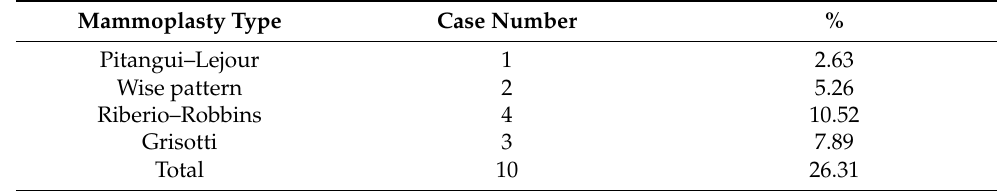
Table 6. Case classification based on the type of mammoplasty performed in Group B.